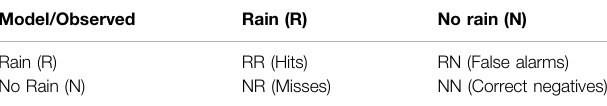
TABLE 3 | Contingency table for the calculation of categorical